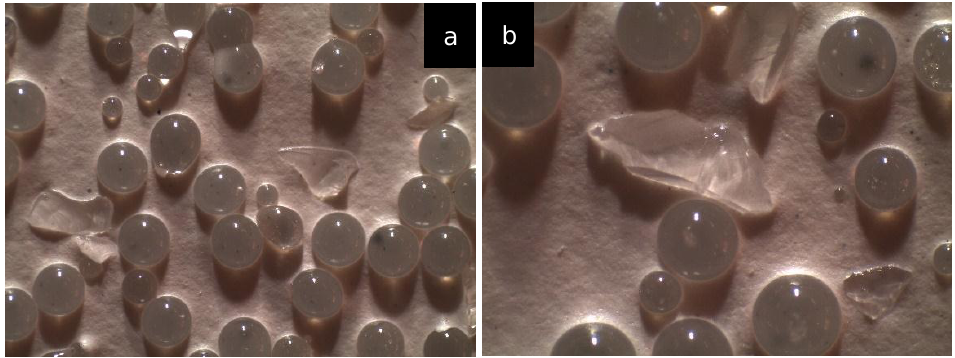
Figure 12. Microscope detail of S15 sample: ( a ) ×16 magnifications; ( b ) ×35 magnifications.